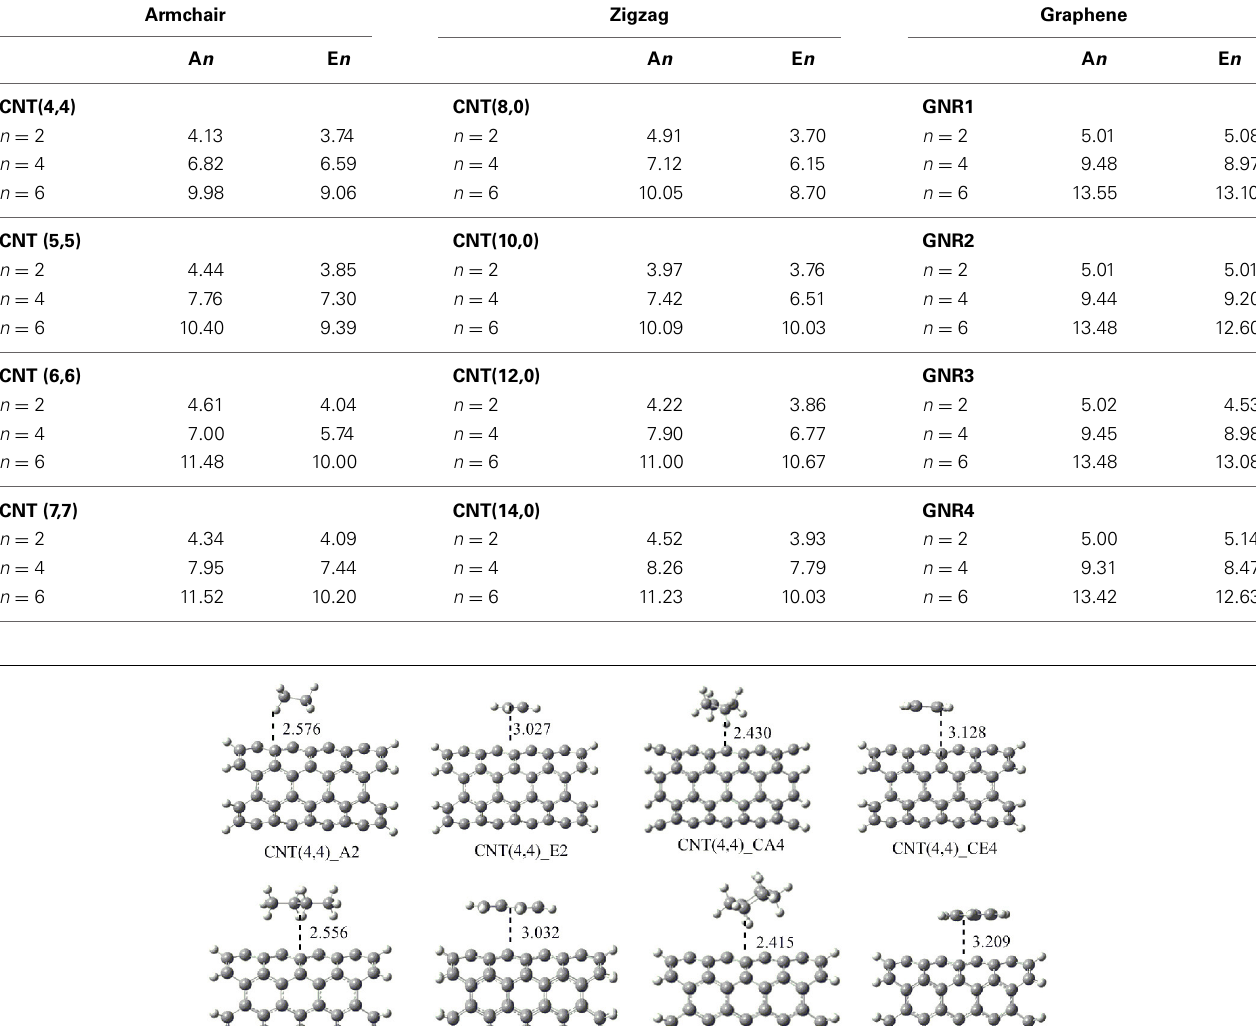
Table 2 | BE (kcal/mol) of CNSs with various acyclic saturated (A n ) and unsaturated (E n ) hydrocarbons at M06-2X/6-311G ** //ONIOM (M06-2X/6-31G * : AM1) level.